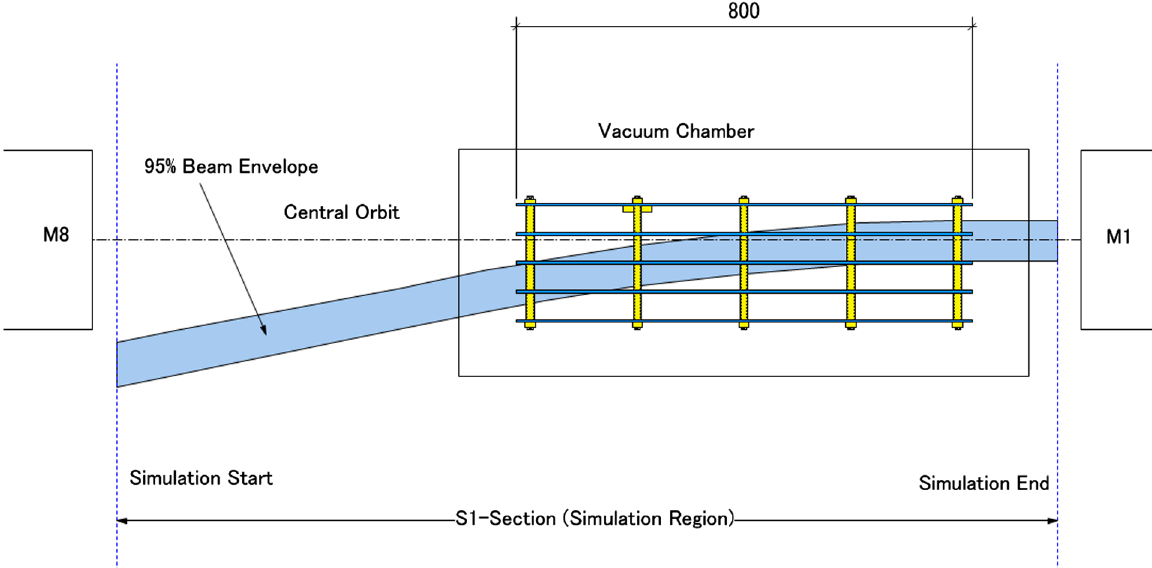
FIG. 16. Top view of the straight section S1 for beam injection including the ES-Kicker. Here, M1 and M8 are ring magnets.